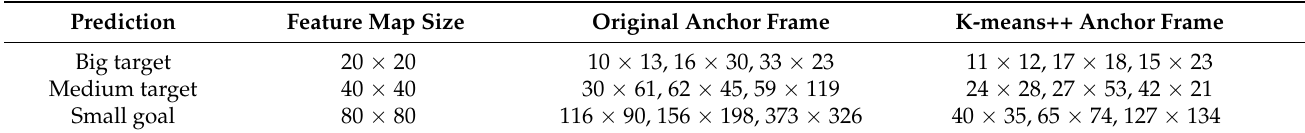
Table 4. The relationship between the selection of anchor frame and feature graph.